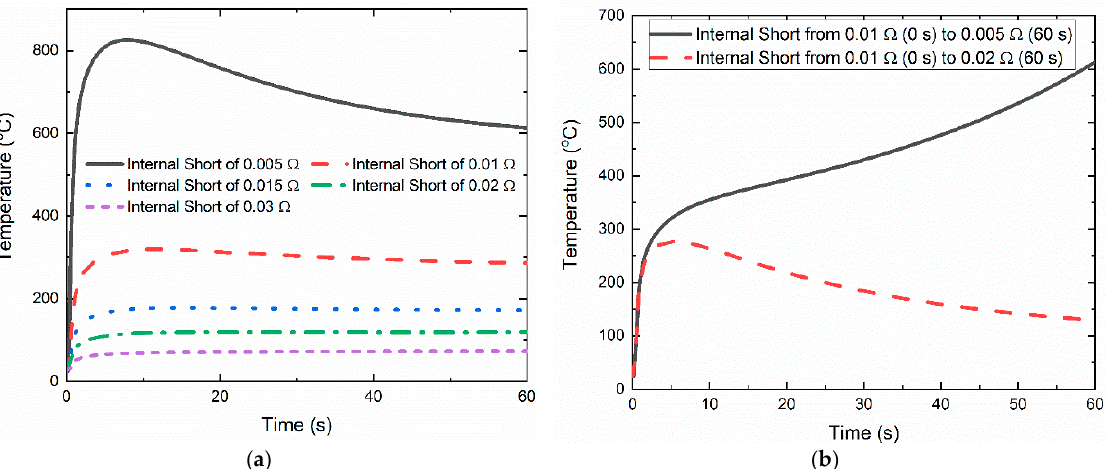
Figure 5. Modeling predicted maximum temperature evolutions on the lithium-ion battery cell under ( a ) different internal shorting resistances; ( b ) internal shorting resistance variation.